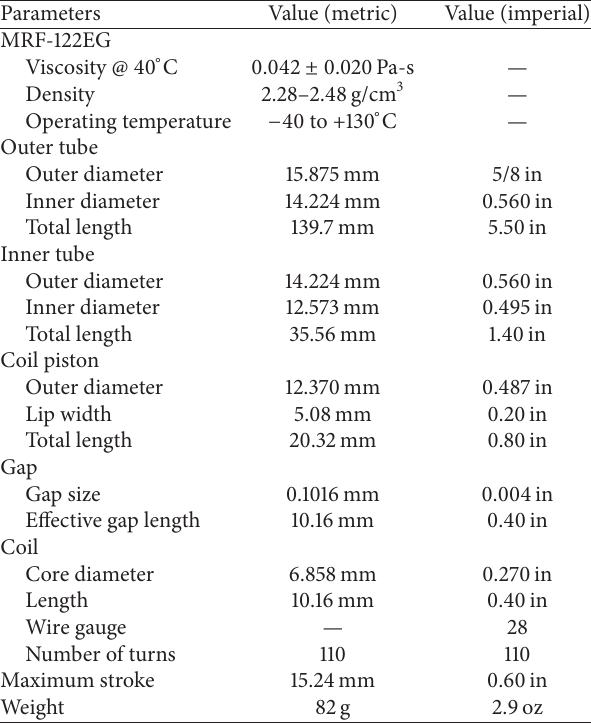
Table 1: Technical specifications of the prototype damper.